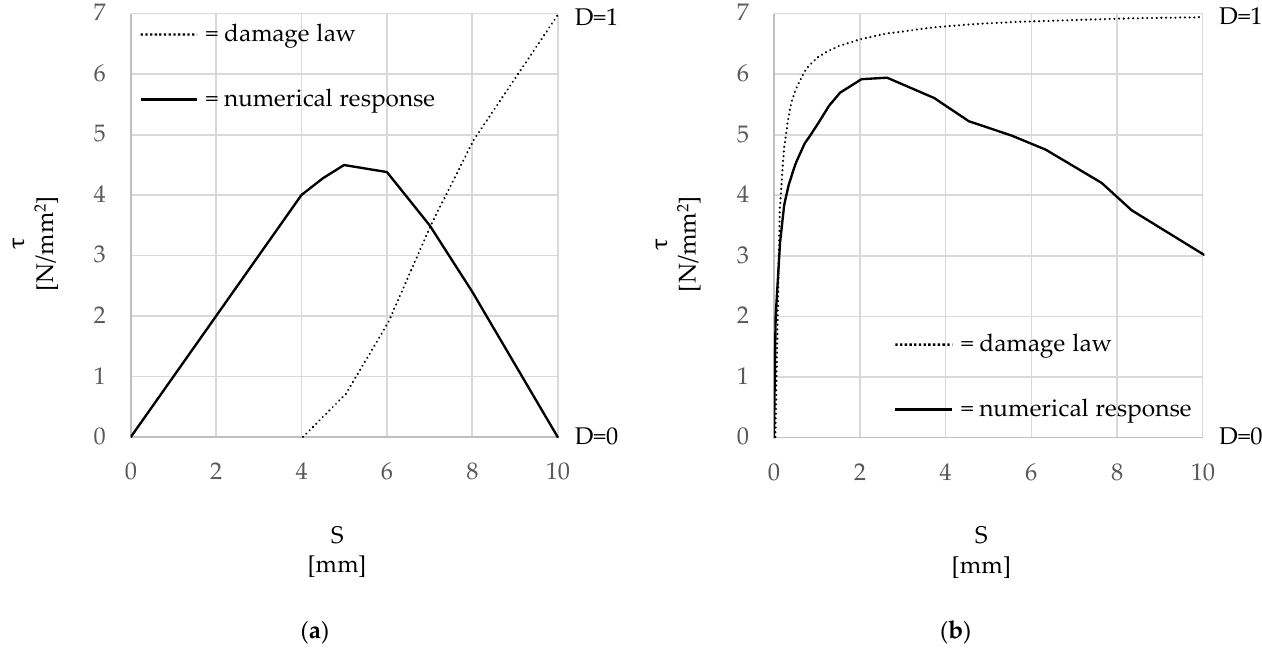
Figure 8. Damage laws proposed with the corresponding τ-slip (τ-S) numerical curve. ( a ) ‘HW-GLT’ system; ( b ) ‘HW-GCF’ system.